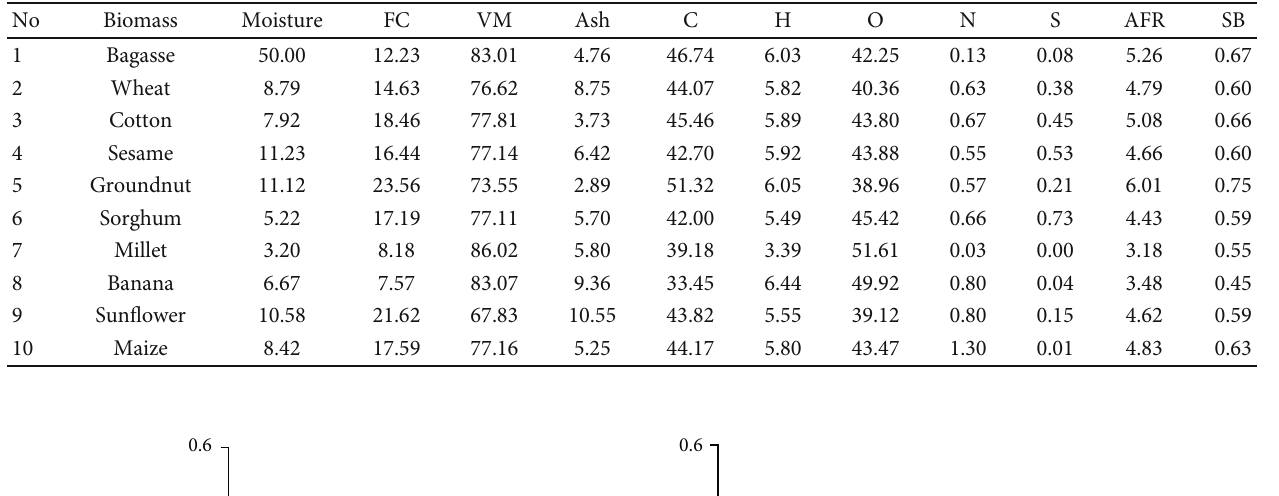
Table 5: Stoichiometric AFR and theoretical